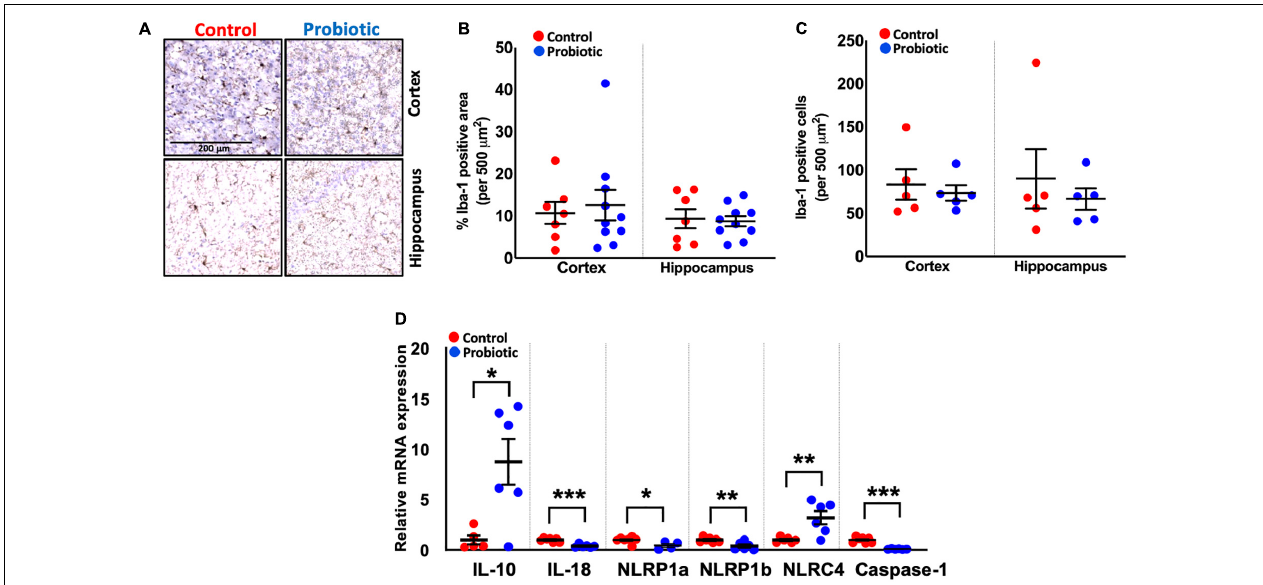
FIGURE 3 | Immune cell composition and the expression levels of inflammatory genes in the brains. (A) Representative images showing Iba-1 staining in the cortex and hippocampus region of the Control and Probiotic groups. (B) Levels of Iba-1 staining and (C) Iba-1 positive cells in the cortex and hippocampus CA1 regions of the Control and Probiotic groups and (D) changes in the relative mRNA expression levels of IL-10, IL-18, NLRP1a, NLRP1b, NLRC4, and Caspase-1 in whole brain extracts of 3xTg-AD mice. Data are expressed as mean ± SEM of 10 mice per group (A,B) or at least five per group (C) . Values of p were determined using unpaired t -test. * p < 0.05, ** p < 0.01, or *** p < 0.001. Iba-1, Ionised calcium binding adaptor molecule 1; IL, interleukin. NLRP1a/NLRP1b, nucleotide-binding oligomerization domain-like receptors (NLR) family pyrin domain containing 1 a/b; NLRC4, NLR family caspase activation and recruitment domains (CARD) domain-containing protein